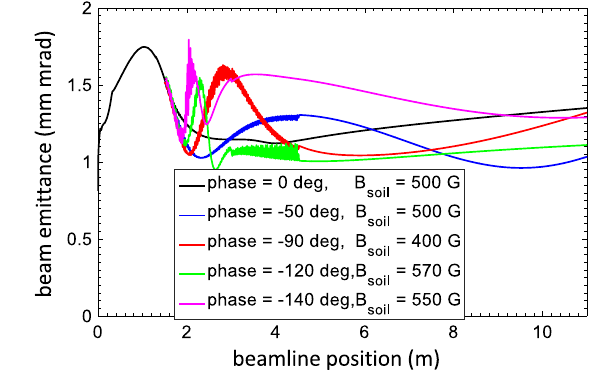
FIG. 3. Changes in rms bunch lengths along the beamline position for different TWA phases, and different phases corre- spond to different compression modes (no compression: 0 deg, under compression: − 50 deg, full compression: − 90 deg, and deep over-compression: − 120 deg and − 140 deg).